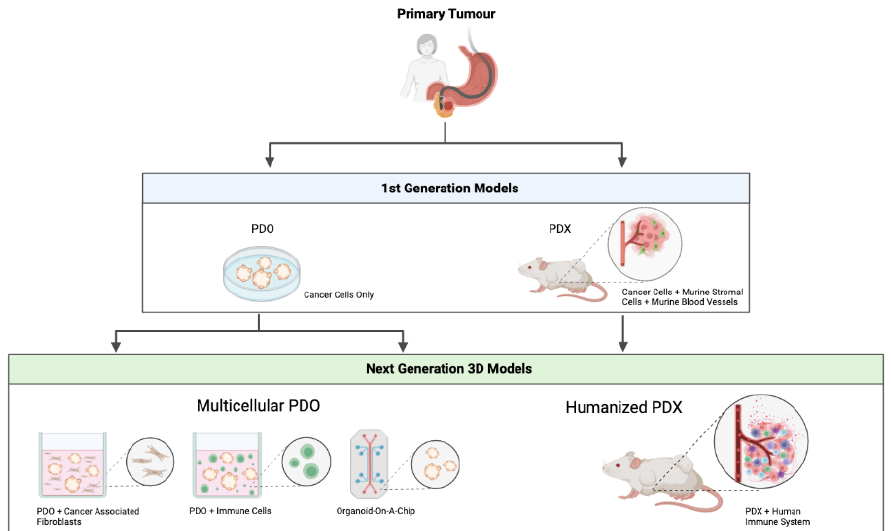
Figure 1. Overview of first and next generation patient-derived models. PDO—patient-derived organoid. PDX—patient-derived xenograft. Figure created with BioRender.com.